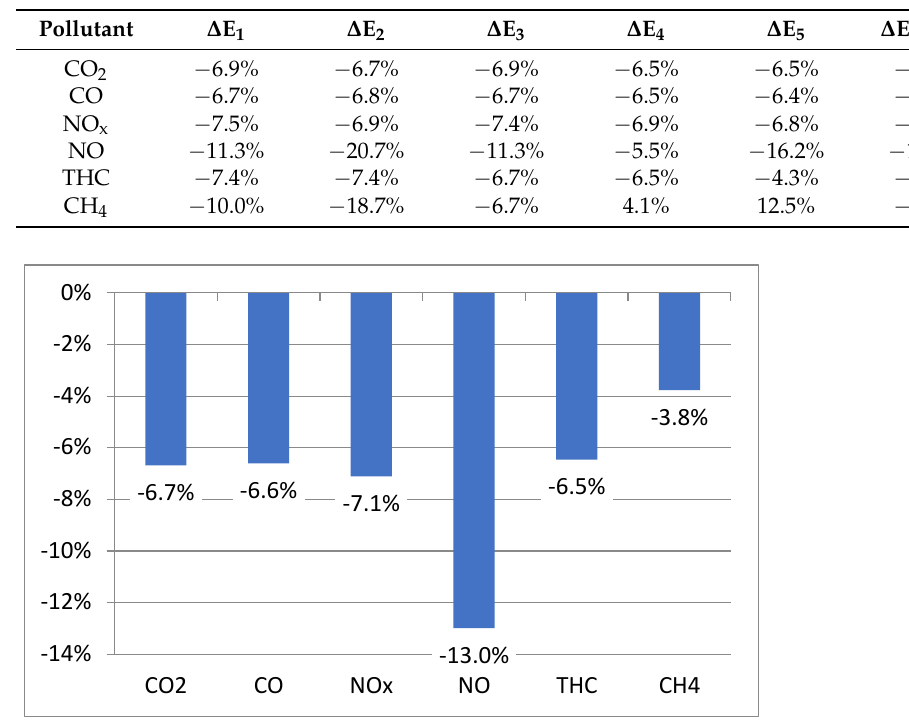
Figure 2. Average relative percentage difference between the pollutant emissions as calculated by the normative method and the corrected method.